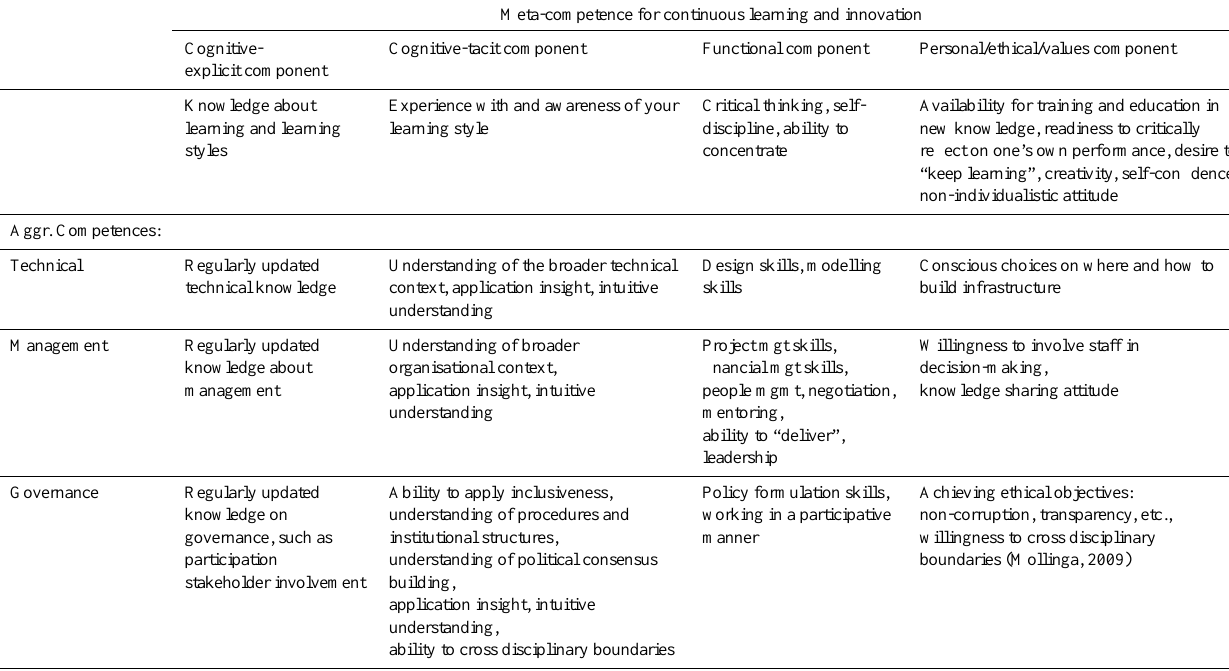
Table 1. Three aggregate competences and one meta-competence for continuous learning and innovation for professionals in the water sector, based on Alaerts and Kaspersma (2009) and Sultana